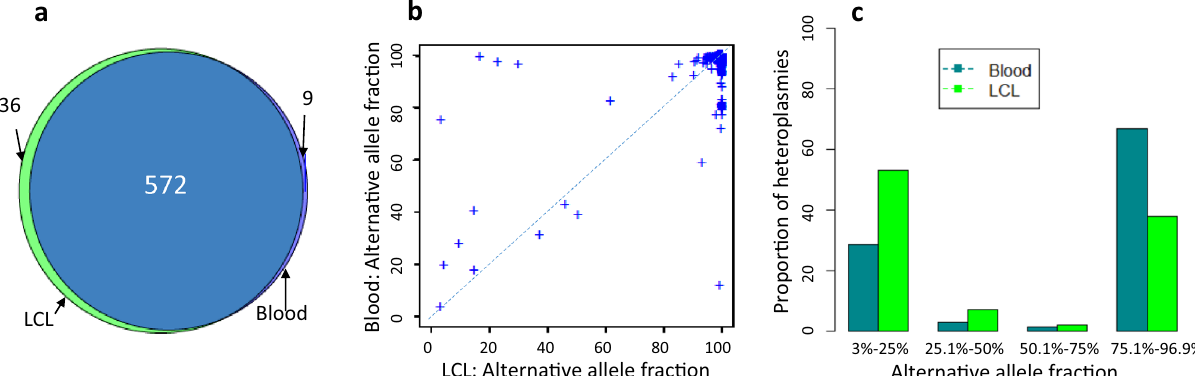
Figure 2. Comparison of homoplasmic sites between the paired LCL and whole blood samples from 130 Framingham Heart Study participants. ( a ) Venn diagram of the observed homoplasmic sites in LCL and whole blood samples. ( b ) Comparison of the AAFs (%) of the 572 homoplasmic sites that are present in both LCL and whole blood samples. ( c ) Comparison of the AAFs of 119 (of 581) and 66 (of 608) sites being heteroplasmic between LCL and whole blood samples ( c ). AAF, alternative allele fractions. LCL, lymphoblastoid cell